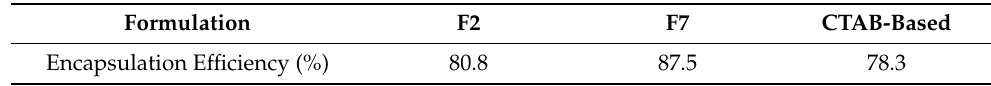
Table 6. Encapsulation efficiency of Formulation F2, Formulation F7, CTAB-based NEs loaded with triamcinolone acetonide.